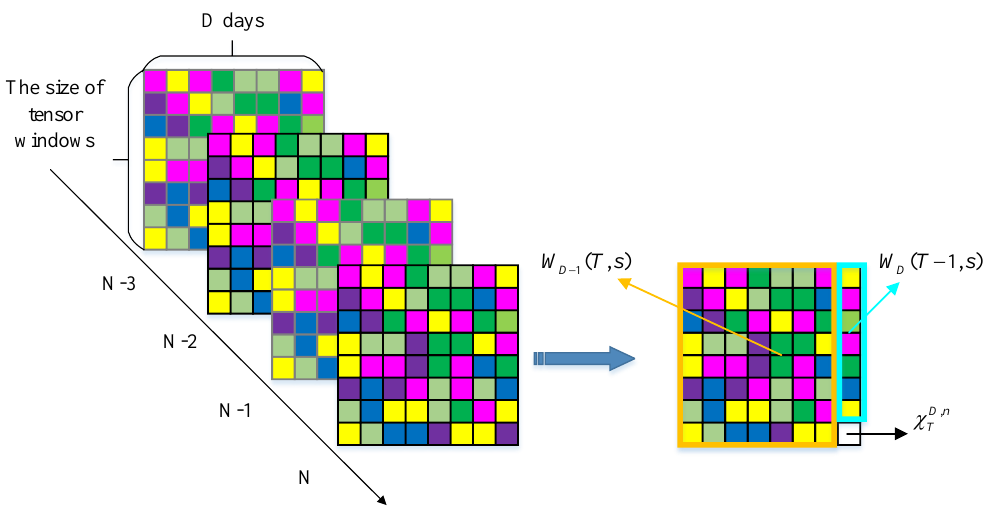
Figure 4. Traffic flow prediction. Algorithm 3 Traffic Flow Prediction Algorithm Based on Data Completion Strategy